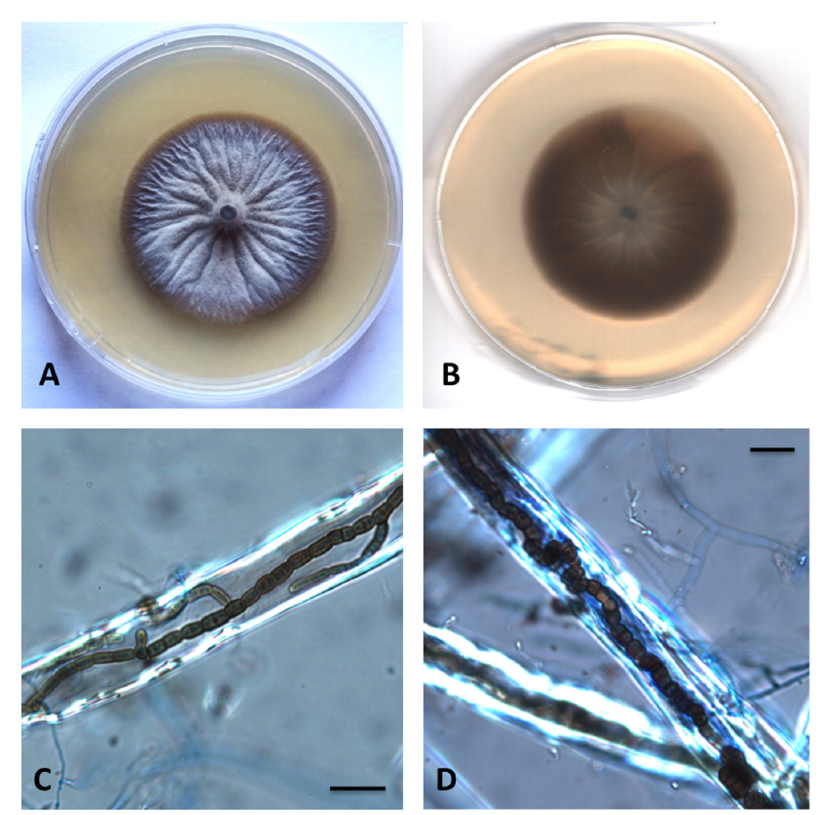
Figure 8. Roussoella padinae sp. nov. 28-days-old colony at 21 °C on MEASW ( A ) and reverse ( B ); toruloid hyphae ( C ) and two-celled chlamydospores ( D ) inside wood vessels. Scale bars: 10 µm.